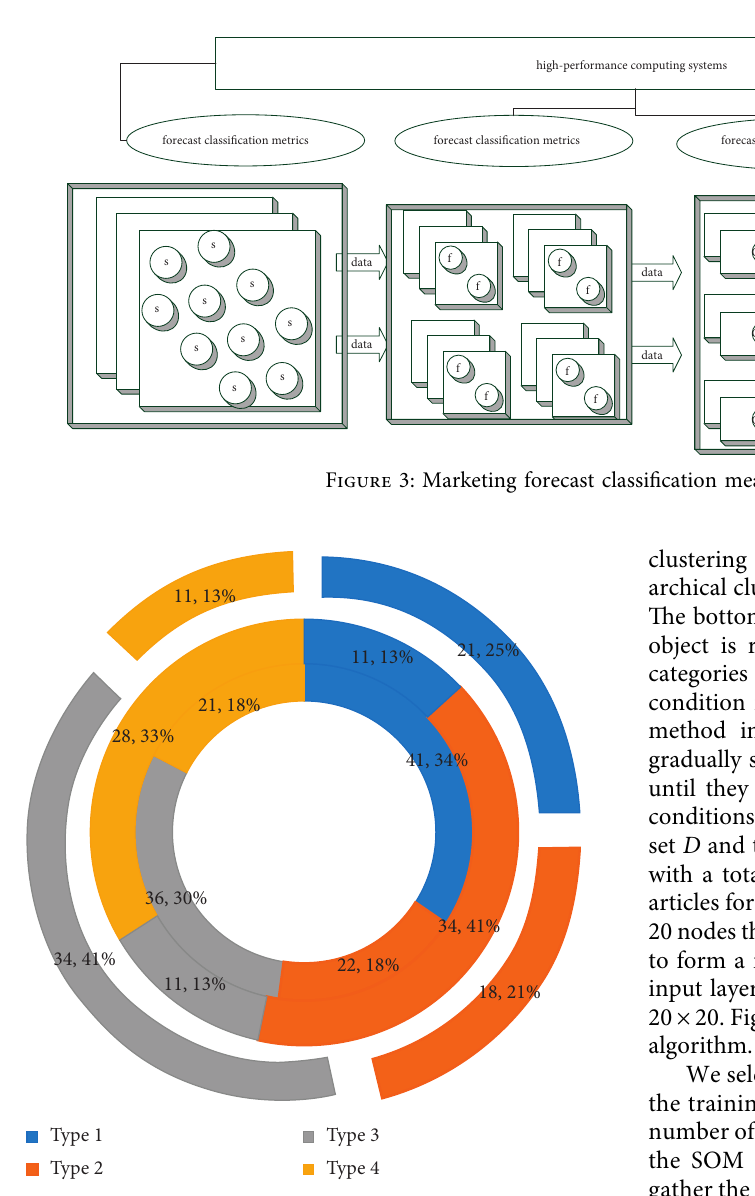
Figure 4: Iterative distribution of model weights.